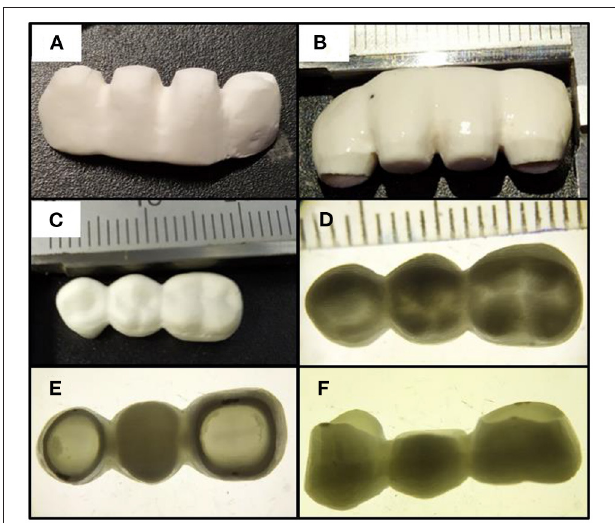
FIGURE 2 | Dental bridges produced by CNC machining (A) sintered alumina incisor bridge, (B) after glazing, (C) sintered 3 yttria-stabilized zirconium oxide (YSZ) molar bridge, (D–F) stereo zoom microscopy in transmittance.